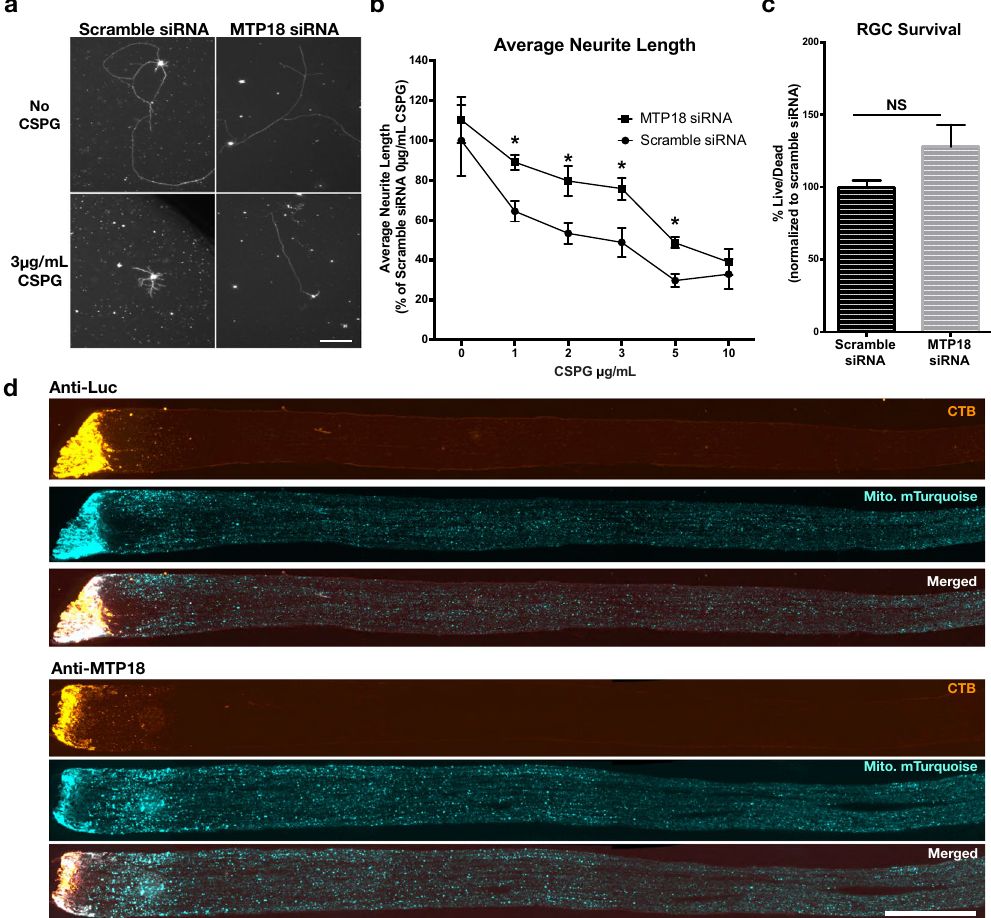
Figure 6. MTP18 knockdown promotes neurite outgrowth on inhibitory substrate but is not sufficient for promoting axon regeneration after optic nerve crush injury. ( a ) Representative images of P4 RGCs neurite growth after electroporation with a non-targeting scramble siRNA or MTP18 targeting siRNA and seeding on PDL + Laminin or PDL + Laminin + CSPGs (3 µ g/ml) for 72 hrs (scale bar 100 µ m). ( b ) Average neurite length of P4 RGCs electroporated with scramble siRNA or MTP18 siRNA and seeded onto different concentrations of CSPGs. All points are N = 4 repeat electroporation experiments per point, normalized to average neurite length of scramble siRNA seeded onto PDL + Laminin only treated wells (significance between scramble and MTP18 siRNA treatments at each CSPG concentration was determined by Student’s t-test, * p ≤ 0.05). ( c ) Scrambled and MTP18 siRNA-electroporated RGCs were plated at the same density as in neurite outgrowth experiments and were assayed for living and dead cells, using calcein AM (green labeled live cells) and sytox (orange labeled dead cells). Tiled images were captured per well and green and red cells were counted and graphed as percent ratio, live over dead cells, normalized to scrambled siRNA controls. (N = 4 repeat electroporation experiments, significance tested for by Student’s t-test, p ≥ 0.05.) See Supplementary Fig. 4a for representative calein Am and Sytox images. ( d ) Representative fluorescent images of P40 rats intravitreally injected with AAV2 Anti-MTP18 or Anti-luciferase virus prior to optic nerve crush. CTB Alexa-555 labeled axons after optic nerves crush show no significant regeneration. Mitochondrial (mito.) mTurquoise labeling from prior virus transduction and merged images with CTB, show degenerate labeling past the crush site and bright linear labeling of some preserved axons, just prior to the crush site (left side of images, scale bar 500 µ m). See Supplementary Fig. 4b,c for RGC survival after optic nerve